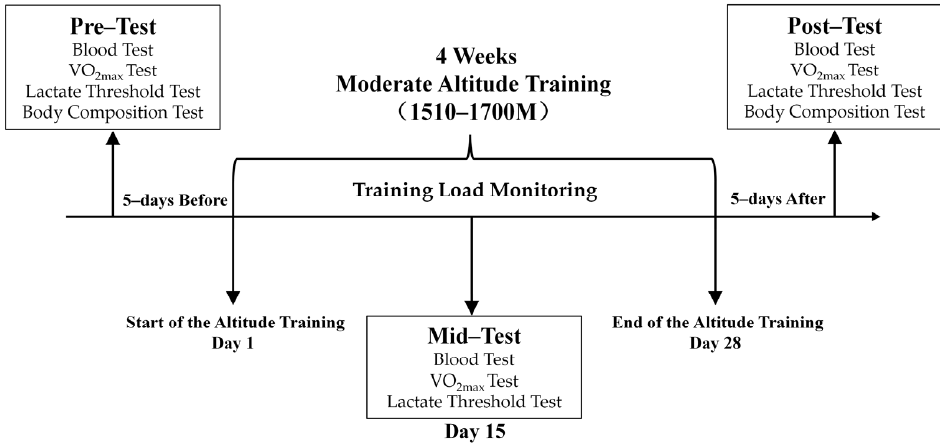
Figure 1. Study Design of the Research.